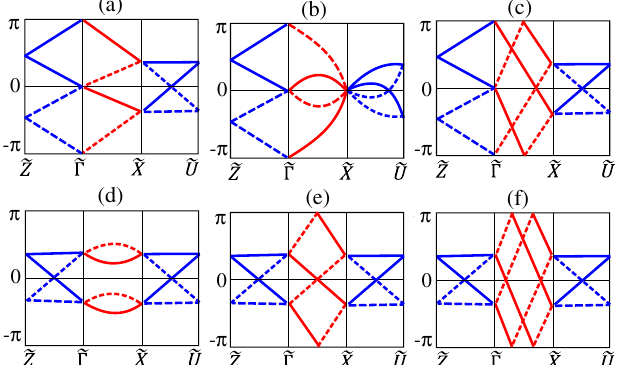
~ Γ ~ X . (a) – (c) With non- ), the mirror-Chern numbers ( C ) are, e Γ , C equals 0, e Γ